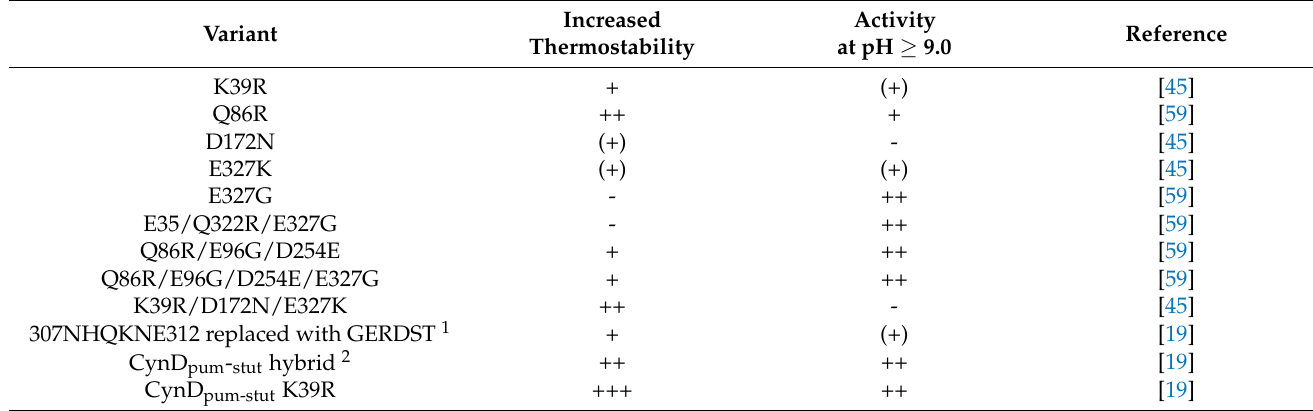
Table 5. Improved variants of cyanide dihydratase from Bacillus pumilus (CynD pum ). Increased Variant Thermostability